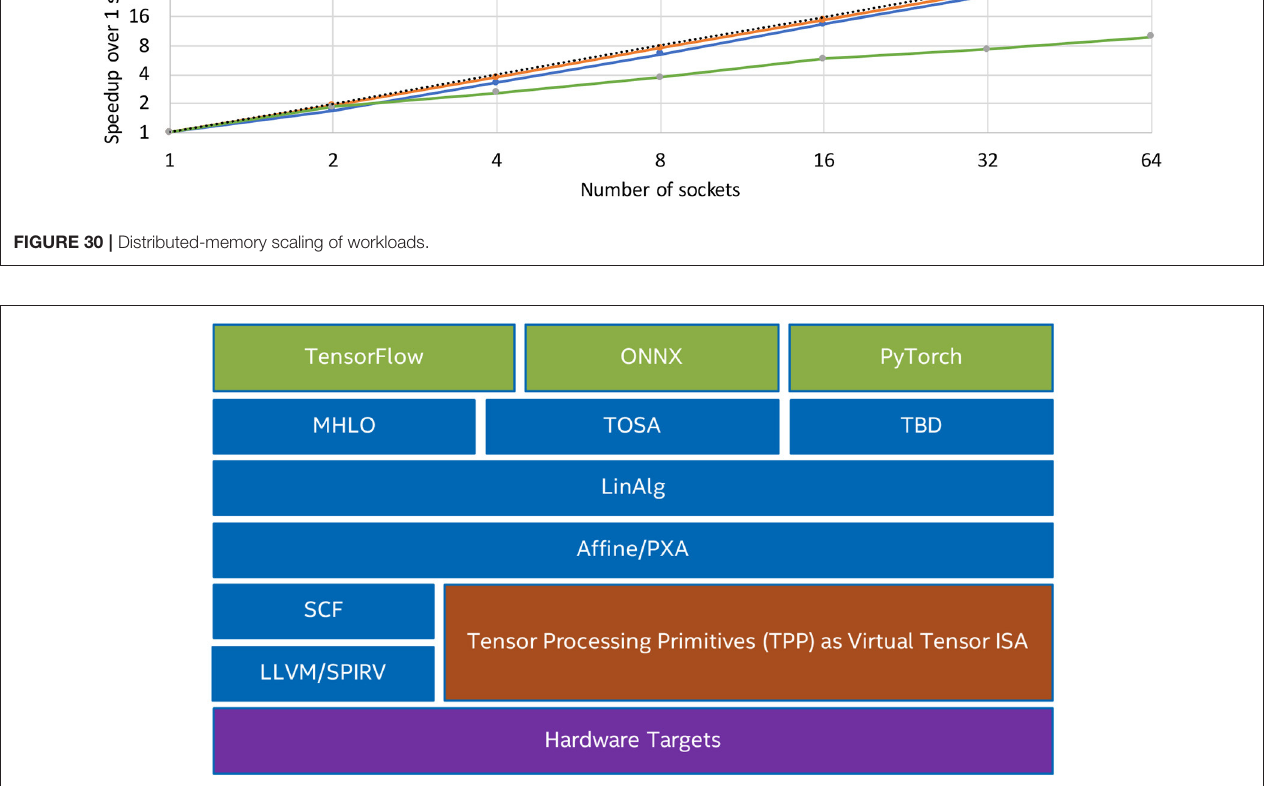
FIGURE 31 | Example lowering paths within the PlaidML Tensor compiler in order to achieve full network optimization from popular frameworks. The green boxes represent the DL frameworks, the blue boxes correspond to MLIR dialects, the brown box shows the TPP-MLIR dialect within the stack, and the purple box represents the targeted